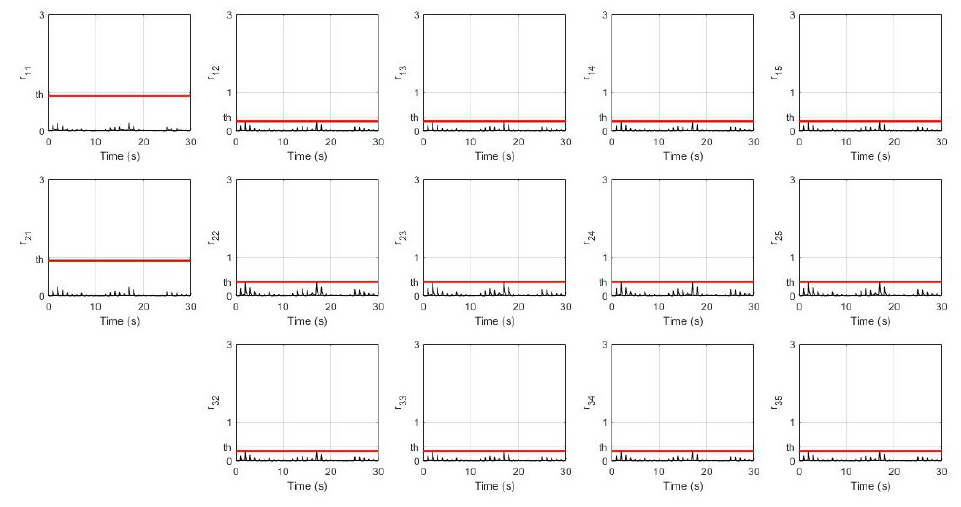
Figure 4. Residual signals without fault.